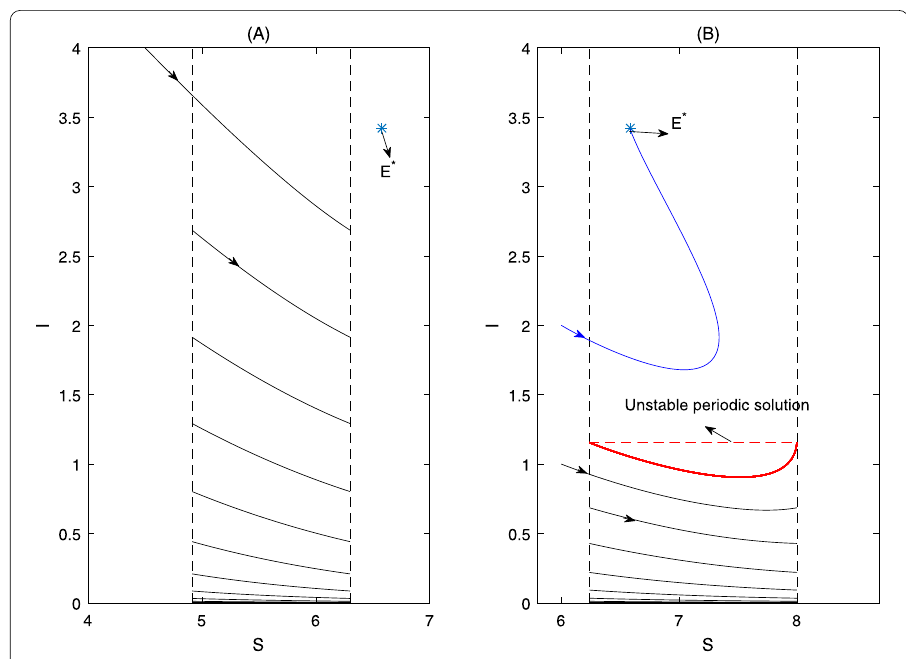
Figure 2 (A) The semi-trivial periodic solution is globally stable. (B) There exists an unstable positive order-1 periodic solution, and the semi-trivial periodic solution and the positive equilibrium E ∗ are bistable. The other parameters are fixed as follows: β = 0.8, A = 7, d = 0.7, v = 4, c = 2.5, θ = 0.1, b = 1, q